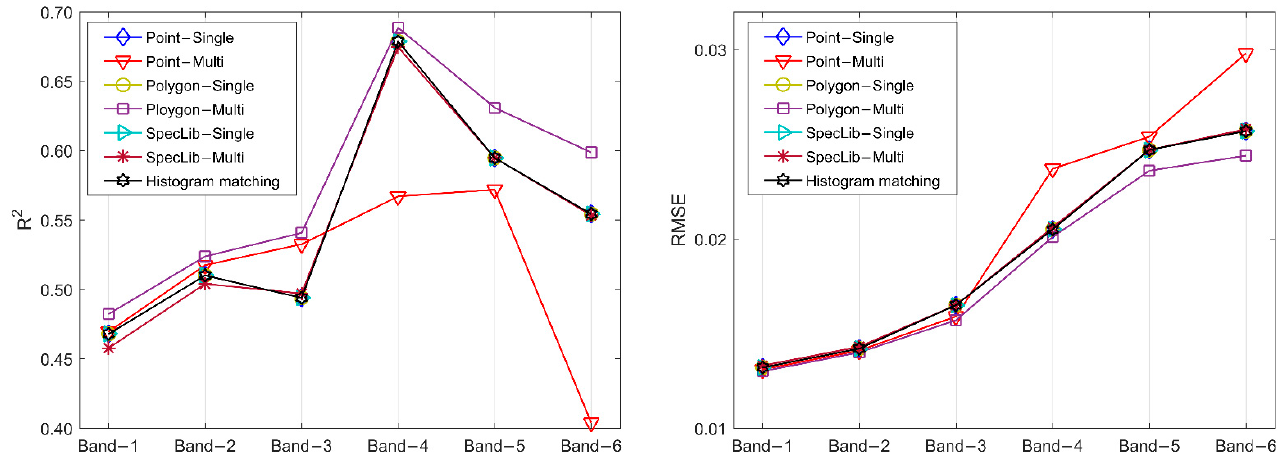
Figure 7. Evaluation of scatter − fitting